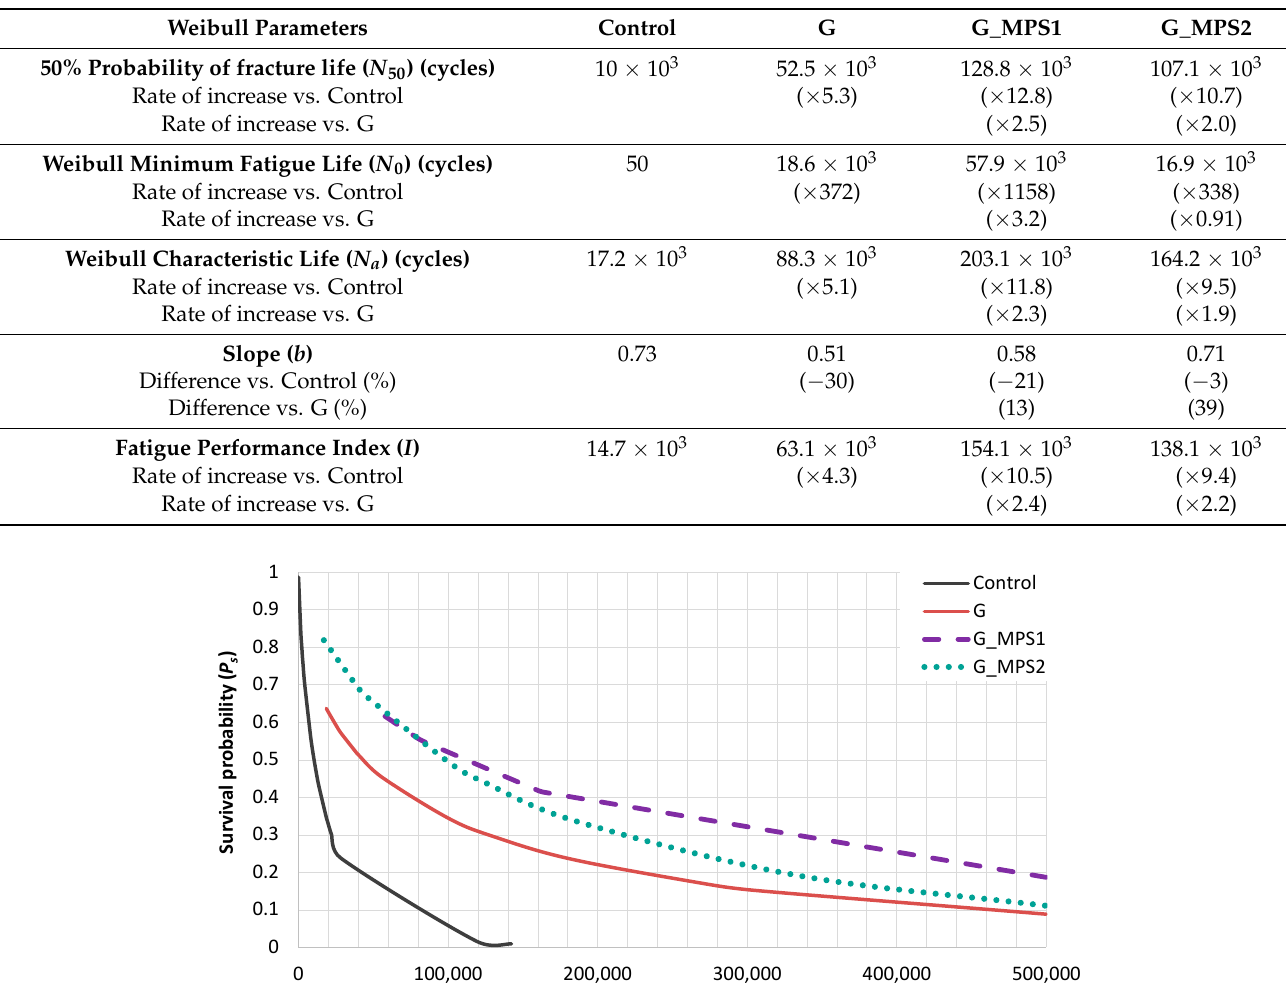
Table 2. Weibull data for the different bone cements. The difference of each value relative to Control and the unsilanised G is expressed as the rate of increase (times that the reference value has increased) in all cases, except for the b parameter which is expressed in percentage (%).